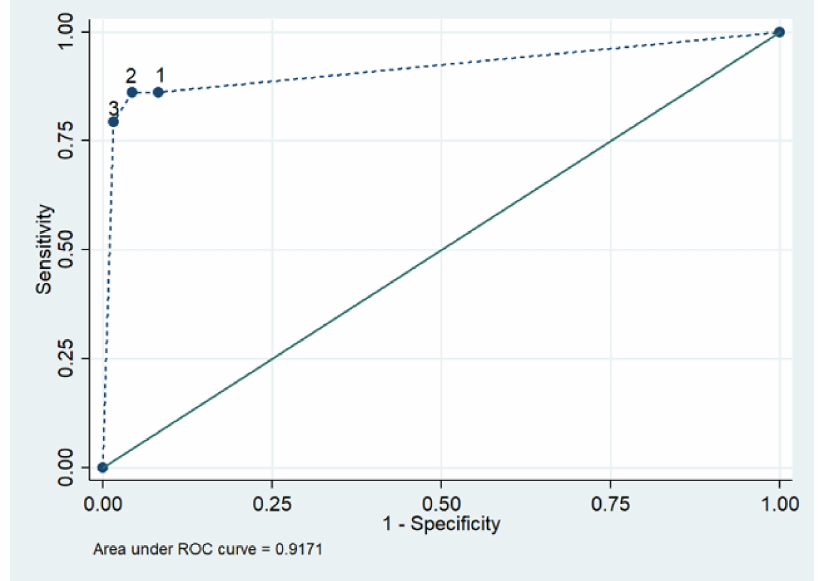
Figure 2. Receiver operating characteristic (ROC) curve of AHA testing in cardiac sarcoidosis. 1 = considering cross-reactive, partially Specific ( p -OS) and organ-specific (OS) AHA patterns as a positive result (sensitivity (SE) = 86.2%; specificity (SP) = 91.8%); 2 = considering p -OS and OS as a positive result (SE = 86.2%; SP = 95.6%); 3 = considering only OS as a positive result (SE = 79.3%; SP =